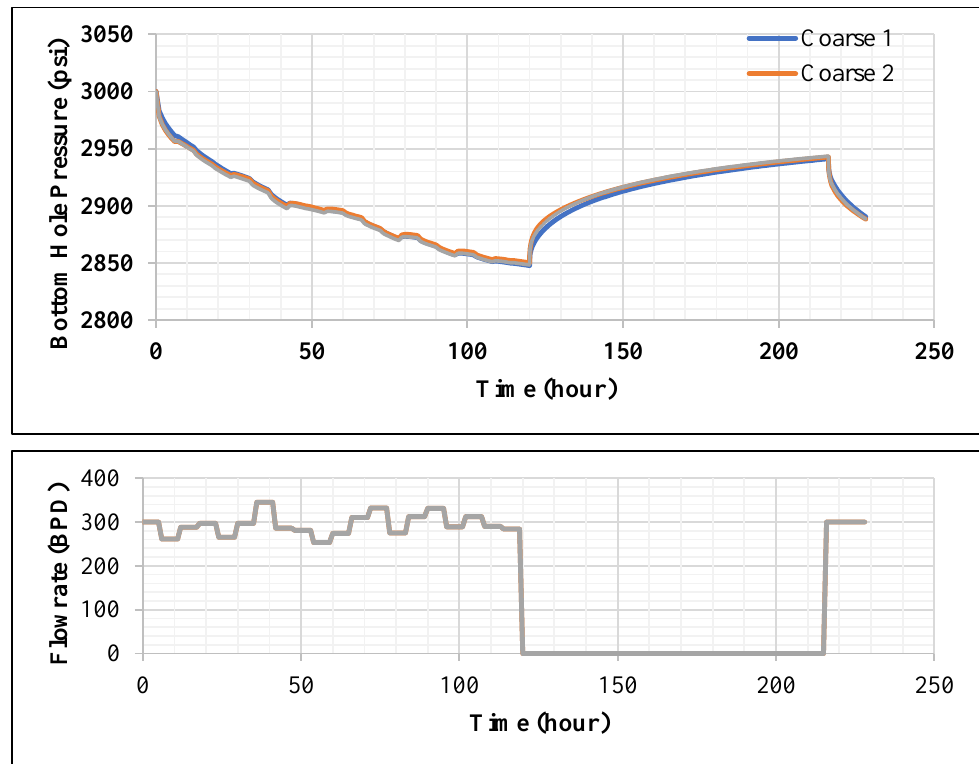
Figure 9. Bottom hole pressure for Coarse Case and Reference in respectively.